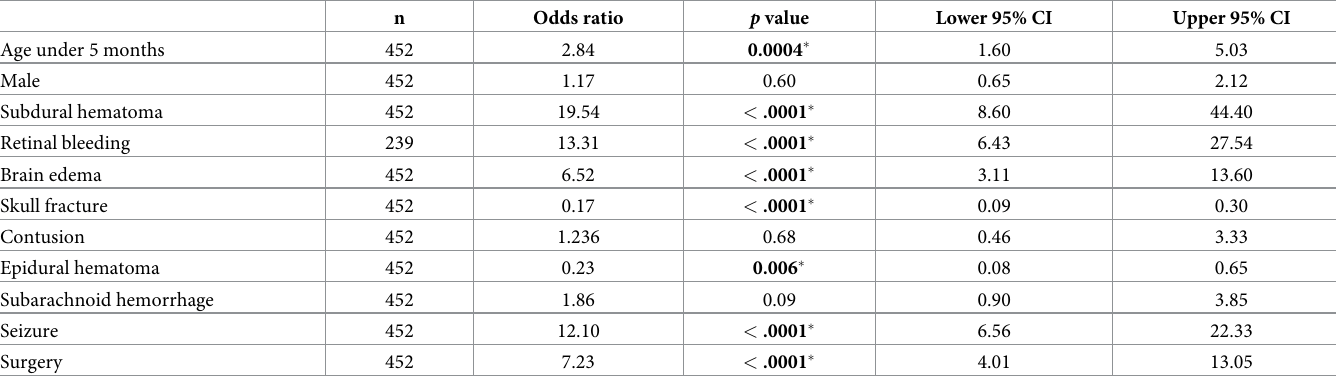
Table 4. Univariate analysis (nonaccidental vs